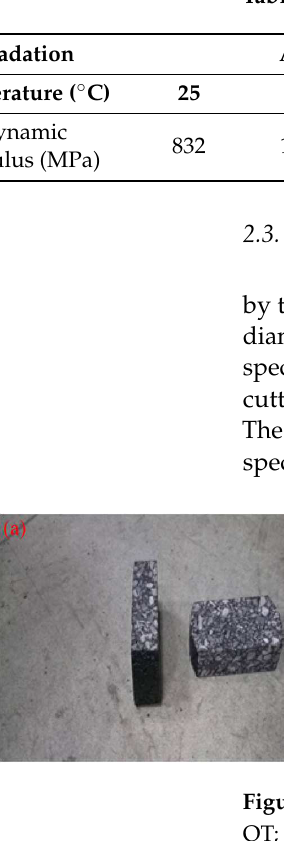
Table 3. Dynamic modulus at different gradations and temperatures.